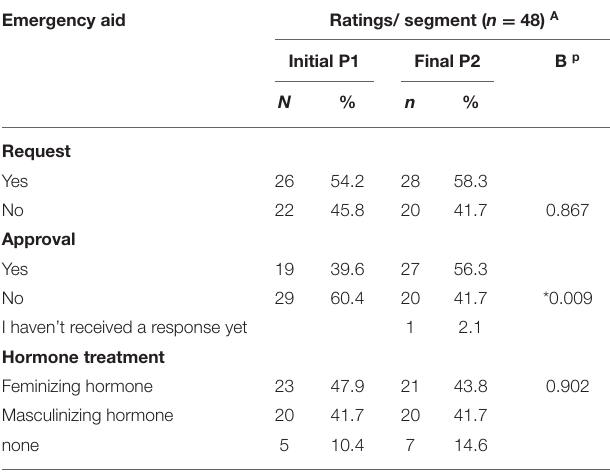
TABLE 3 | Absolute and relative distribution for the request and approval of emergency assistance and for treatment and surgical procedure in the initial (P1) and final (P2)